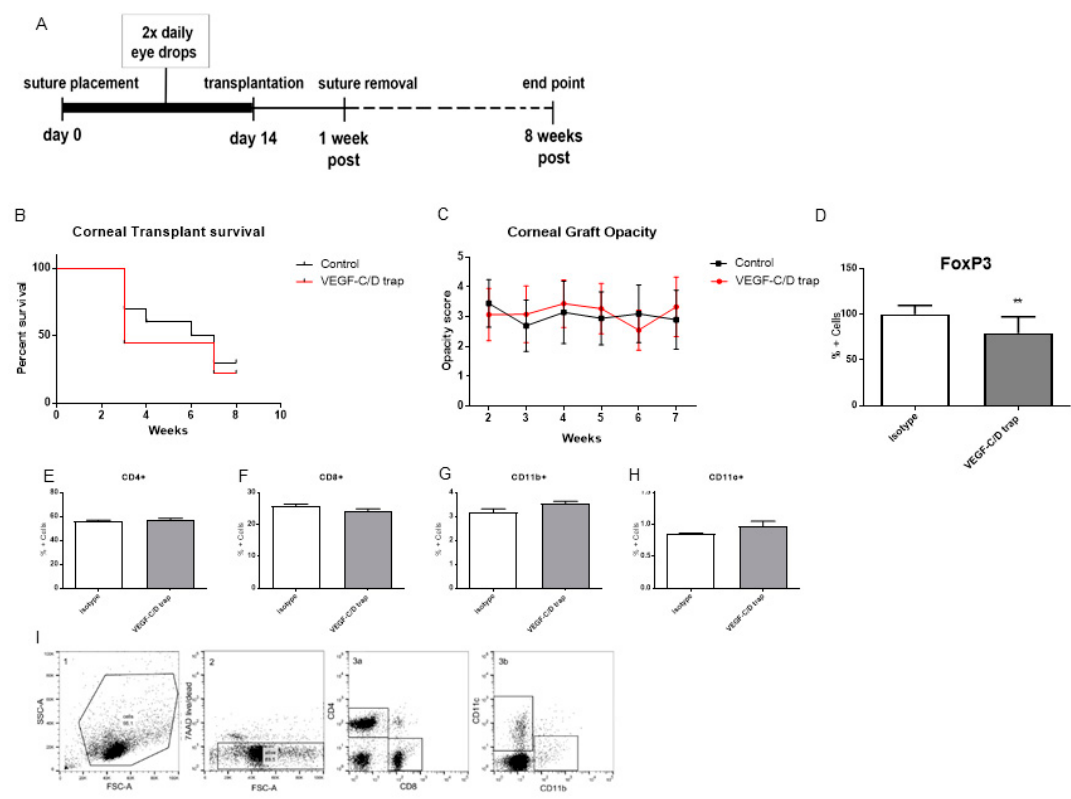
Figure 5. VEGF-C / D blockade did not improve corneal transplantation ( A ) Outline of Corneal transplantation model; ( B ) Corneal graft survival was not improved by VEGF-C / D trap treatment, p = ns, n = 10; ( C ) Opacity of corneal grafts after transplantation over time; ( D ) FoxP3 + T cell frequency was significantly reduced in the VEGF-C / D treatment group; ( E , F ) CD4 + and CD8 + cell numbers were not altered, p = ns, n = 9; ( G , H ) CD11b + and CD11c + cell frequencies were the same between groups, p = ns, n = 10; ( I ) Gating strategy for Immune cells: 7AAD negative cells (alive) (2), gated for for CD4 and CD8 (3a) or CD11c or CD11b (3b). (** p =